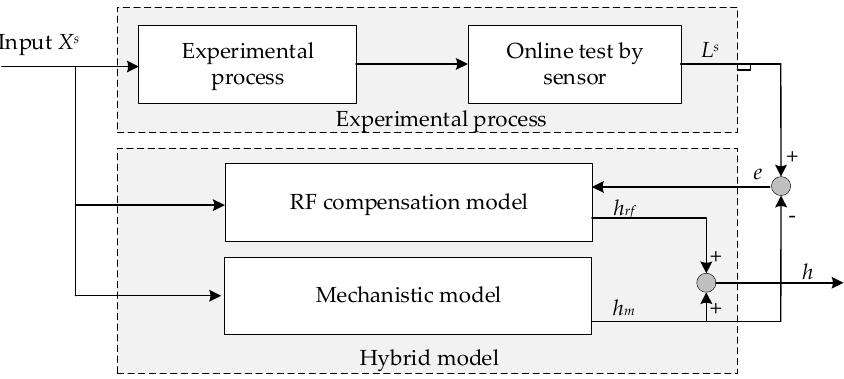
Figure 3. The schematic of parallel hybrid model for stable state. RF: Random forest.